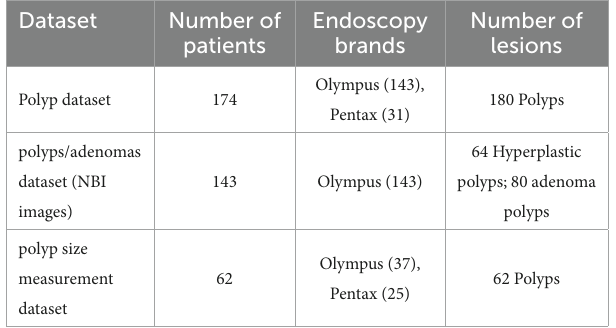
TABLE 2 Basic information of clinical validation